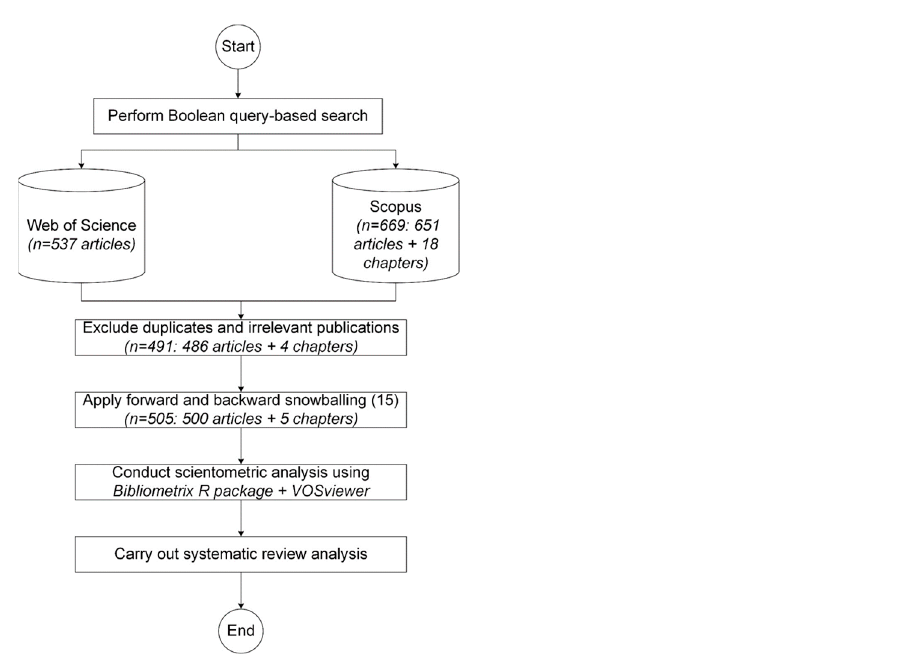
Figure 2. Boolean query string in Web of Science database.